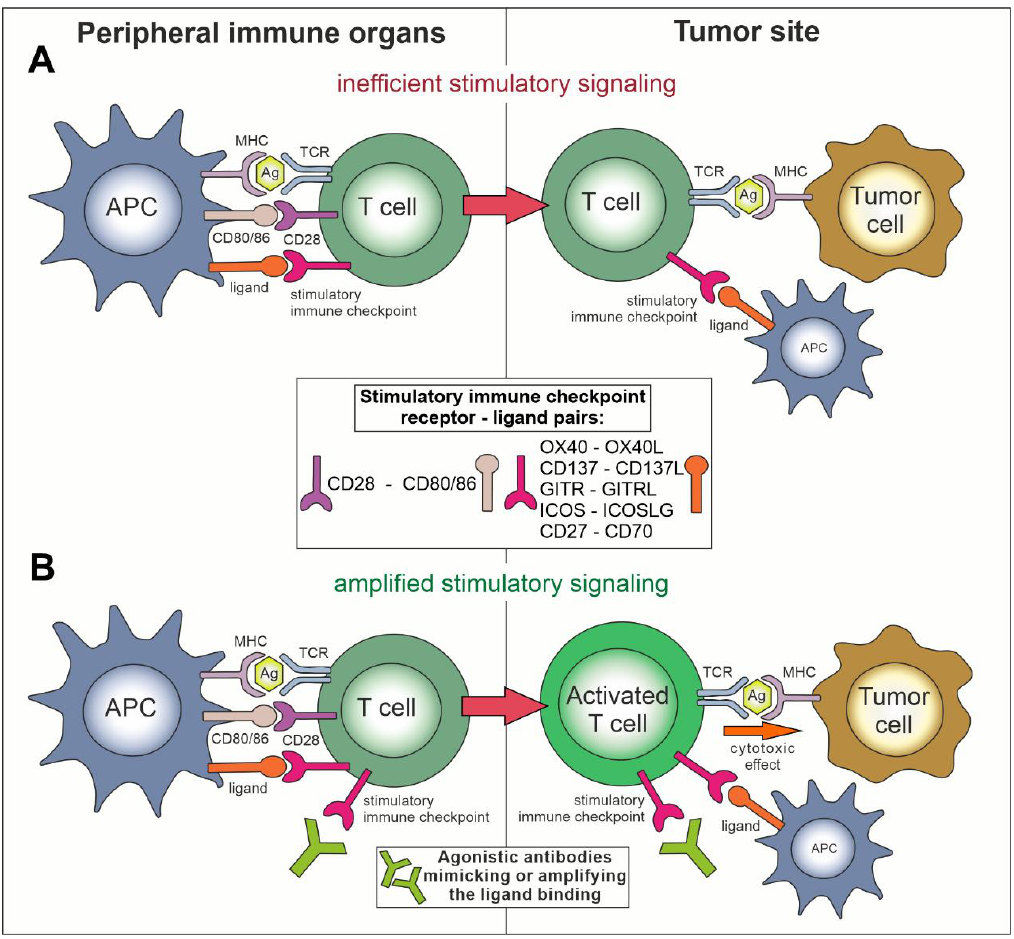
Figure 2. Targeting the positive immune checkpoints with monoclonal antibodies. ( A ) The mechanism of stimulation of a T cell effector function via positive immune checkpoints. The of stimulation of a T cell e ff ector function via positive immune checkpoints. The interaction of CD28 interaction of CD28 with its ligands, CD80 or CD86, follows TCR signaling and co-stimulates immune with its ligands, CD80 or CD86, follows TCR signaling and co-stimulates immune cell activation. Some cell activation. Some of the other stimulatory immune checkpoints may also provide a co-stimulatory of the other stimulatory immune checkpoints may also provide a co-stimulatory signal, but most of them signal, but most of them start being expressed on already activated immune cells. In advanced cancer, start being expressed on already activated immune cells. In advanced cancer, this positive signaling is, this positive signaling is, however, often insufficient for eliminating the malignant cells. ( B ) however, often insu ffi cient for eliminating the malignant cells. ( B ) Application of agonistic antibodies Application of agonistic antibodies mimicking or amplifying binding of the ligands for stimulatory mimicking or amplifying binding of the ligands for stimulatory immune checkpoints increases e ff ector immune checkpoints increases effector activity of T cells towards tumor cells with prospective activity of T cells towards tumor cells with prospective elimination of cancer elimination of cancer cells.